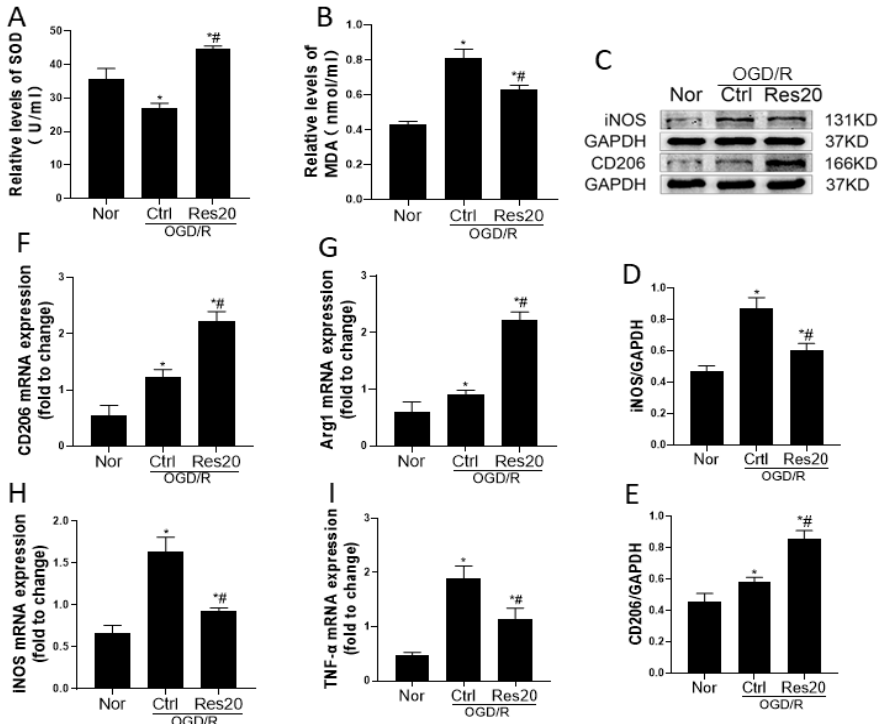
Figure 2. Resveratrol pretreatment ameliorates oxidative damage and regulates M1/M2 polarization of N9 microglia following OGD/R injury in vitro . ( A ) SOD activity detected by WST-1 assay. ( B ) MDA level detected by TBA assay. ( C ) Protein expressions of iNOS and CD206 with Western blot analysis. ( D,E ) Quantification of data for iNOS and CD206 proteins. ( F – I ) The levels of CD206, Arg1, iNOS and TNF- α mRNA were detected by RT-PCR. * p < 0.05, vs. Nor group; # p < 0.05, vs. Ctrl group. Data are presented as the mean ± standard deviation and were compared using a one-way analysis of variance ( n = 3 for each group). OGD/R, oxygen-glucose deprivation/reoxygenation; Nor, normal; Ctrl, control; Res20, 20 μM resveratrol.